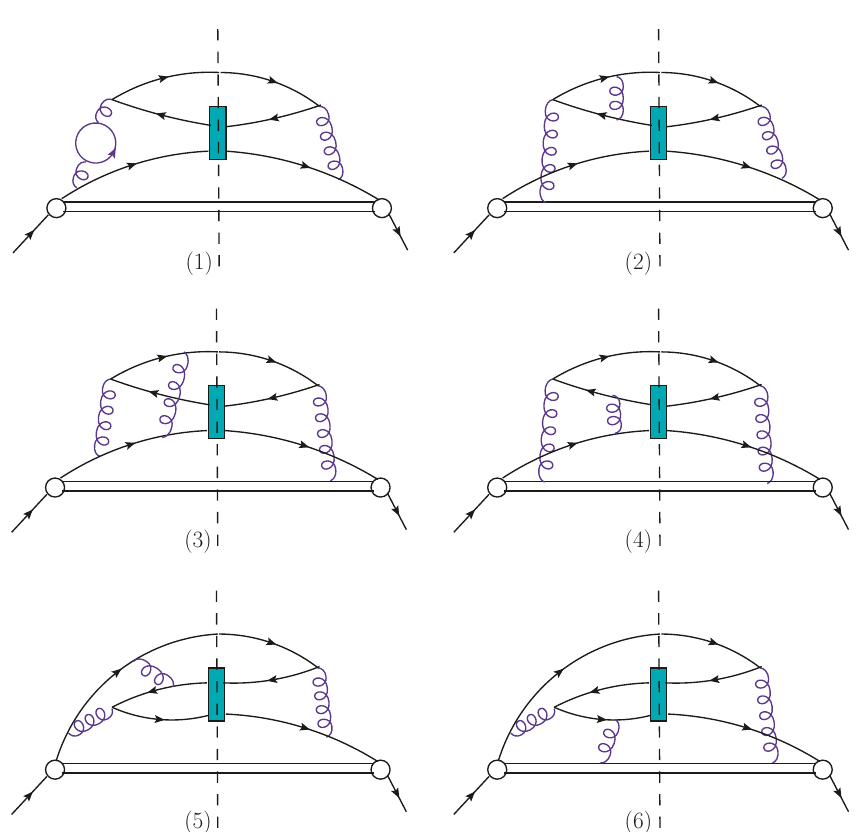
Figure 2 . Six sample cut diagrams for the virtual corrections to the fragmentation function D Q → ( Q ¯ Q )[ 1 S [1] 0 ]